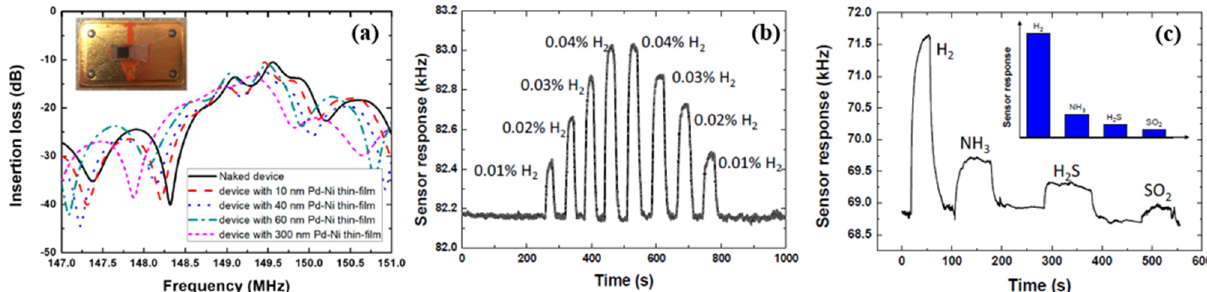
Figure 8. ( a ) Measured frequency responses of the proposed sensing device depending on the Pd–Ni thin-film thickness, inset: picture of the prepared sensing device; ( b ) measured sensor responses relating to the 40 nm Pd–Ni alloy thin-film coated sensing device to various hydrogen gas concentrations; ( c ) selectivity testing of the proposed Pd–Ni alloy thin-film coated sensing device. [39]. Copyright (2017), with permission from MDPI.